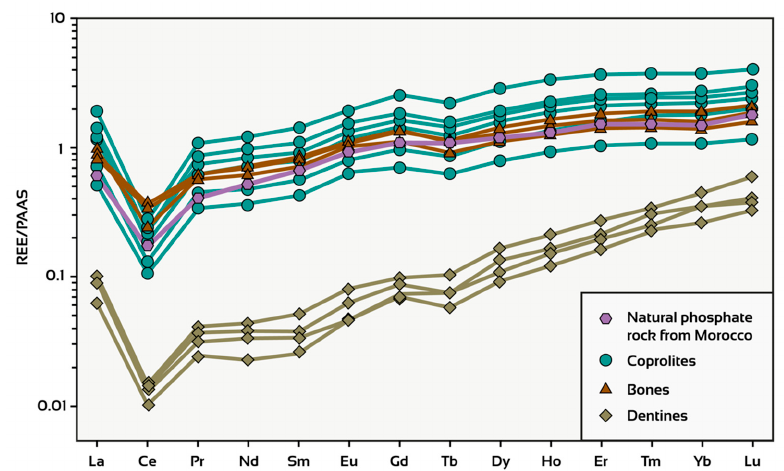
Figure 7. PAAS-normalized REE patterns for different phosphate bioparticles (coprolites, bones, and dentines) [98,99] compared to natural phosphate rock from Morocco